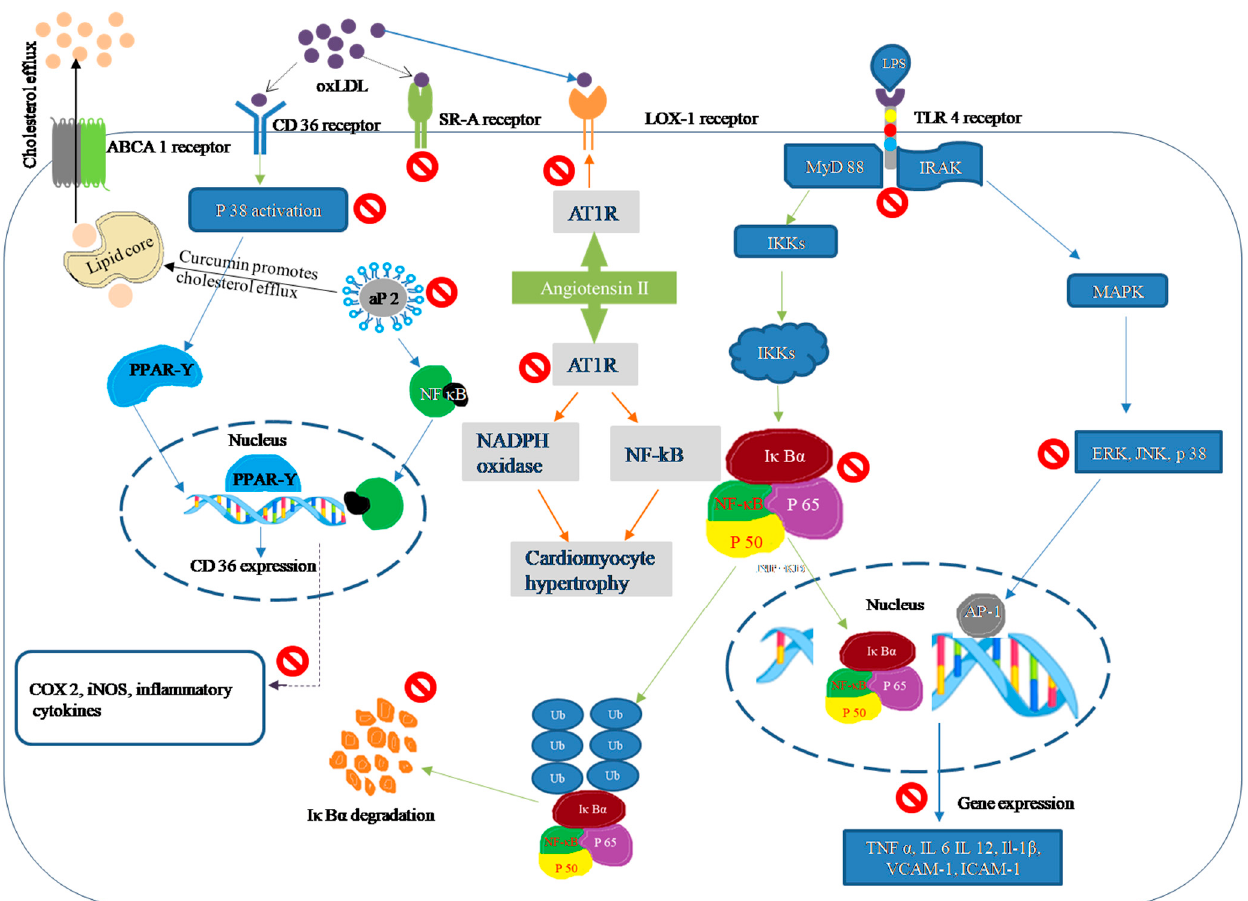
Figure 1. Pharmacological effects and mechanism of action of curcumin in atherosclerosis.